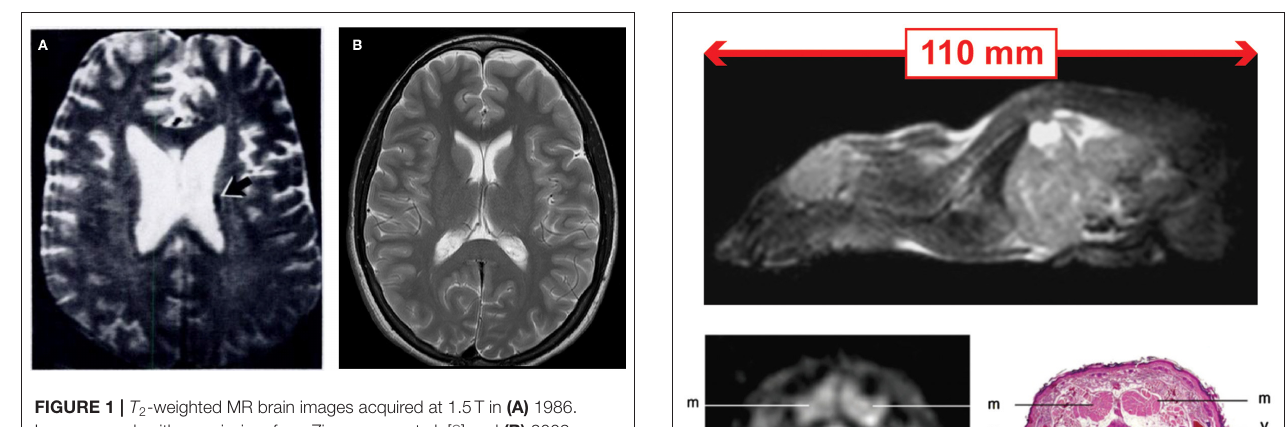
430 µ m 2 . The × 1mm thickness. (Bottom) Tail: ∼ 100 µ m 2 . The × 750 µ m thickness. Images ∼